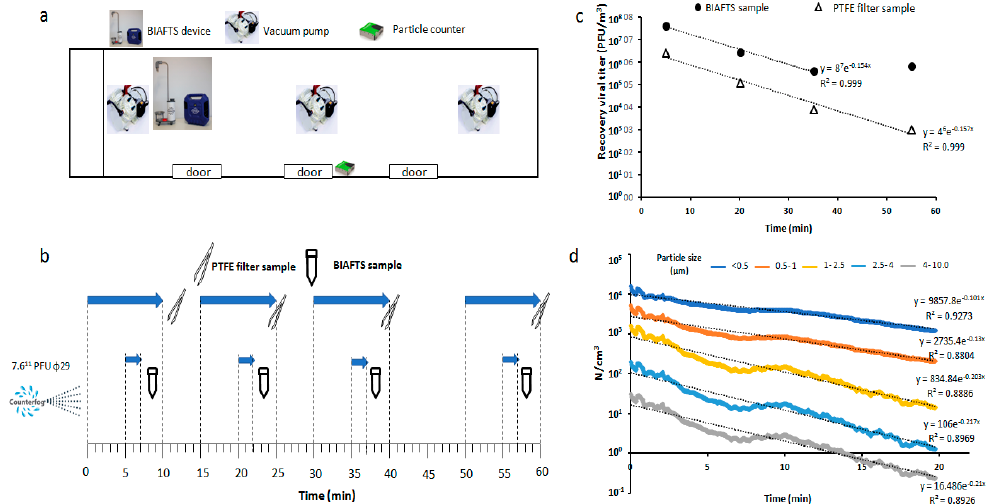
Figure 3. Bioaerosol dynamics and capture tests in a railway car. ( a ) Railway car diagram that shows the space distribution of air samplers and particle counter. ( b ) Timeline and experimental design of bioaerosol tests. A unique bacteriophage ɸ 29 aerosolization was performed in a 157 m 3 railway car, and samples were taken over the course of 1 h. Sampling time: 2 min for BIAFTS and 10 min for PTFE filters. ( c ) Viral titer of bacteriophage ɸ 29 (PFU/m 3 ) recovered using BIAFTS and PTFE filtra- tion. ( d ) Natural aerosol decay measured in number of particles/cm 3 for different particle sizes: ≤ 0.5 μ m (dark blue), 0.5–1 μ m (red), 1–2.5 μ m (yellow), 2.5–4 μ m (light blue), and 4–10 μ m (grey).